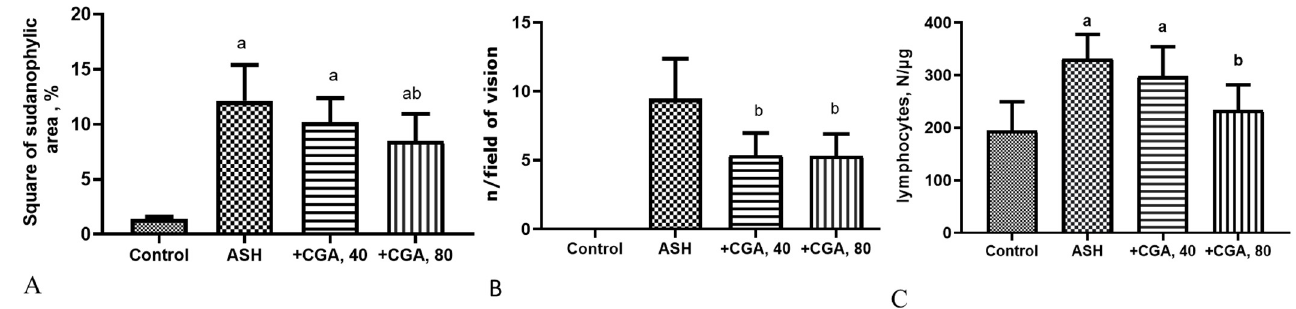
Figure 2. Results of morphometric evaluation of liver slides. ( A )—The relative square of the sudanophylic area reflects accumulation of neutral lipids into hepatocytes; ( B )—The number of inflammatory foci per the field of vision. ( C )—The inflammatory cells (leucocytes) count in the liver (number of cells/mg tissue); M ± SD; a— p < 0.05 compared to the control group; b— p < 0.05 compared to the ethanol-administered group.